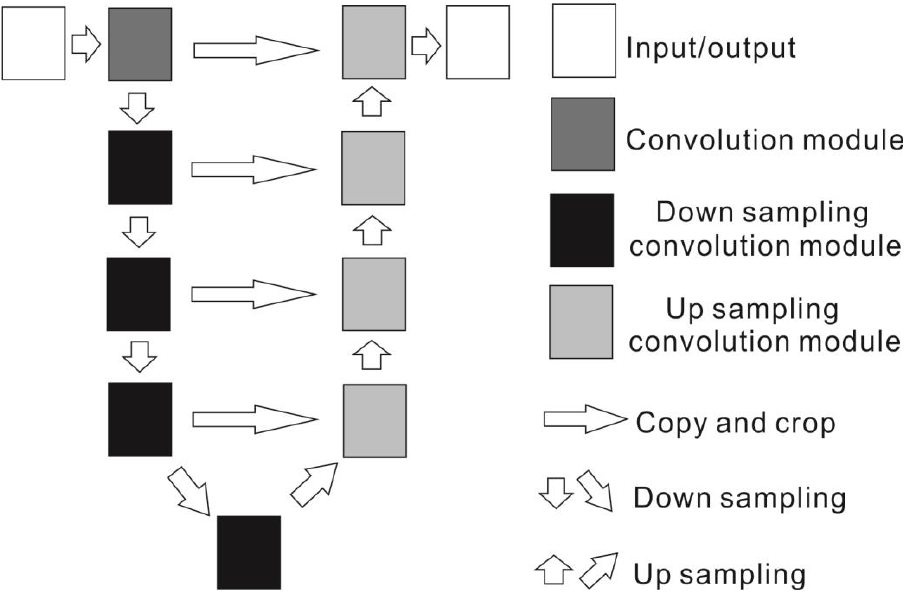
Figure 6. The structure of the U-Net algorithm.